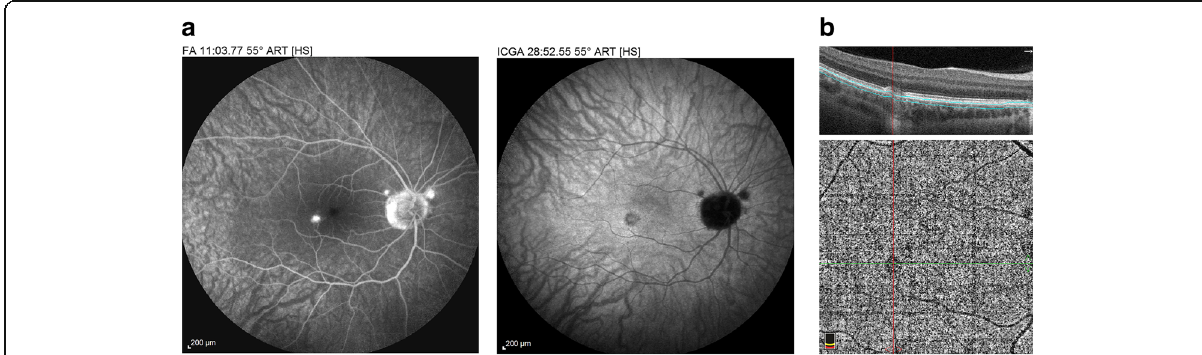
Fig. 4 Multifocal choroiditis (MFC): CNVs. Small parafoveal CNV brightly hyperfluorescent on FA (left frame) and also hyperfluorescent on ICGA (right frame). On the other hand, the two paramacular atrophic scars are hyperfluorescent on FA (left frame) but are hypofluorescent on ICGA (right frame). b. Multifocal choroiditis (MFC) - CNVs. Shown by OCTA (same patient as Fig. 4a)